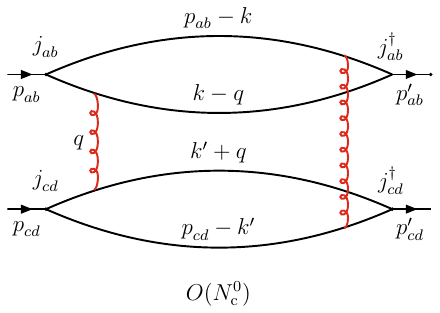
Fig. 24 Two-gluon exchanges between the disconnected pieces of the direct channel I [Eq. (2.3) and Fig. 1b]